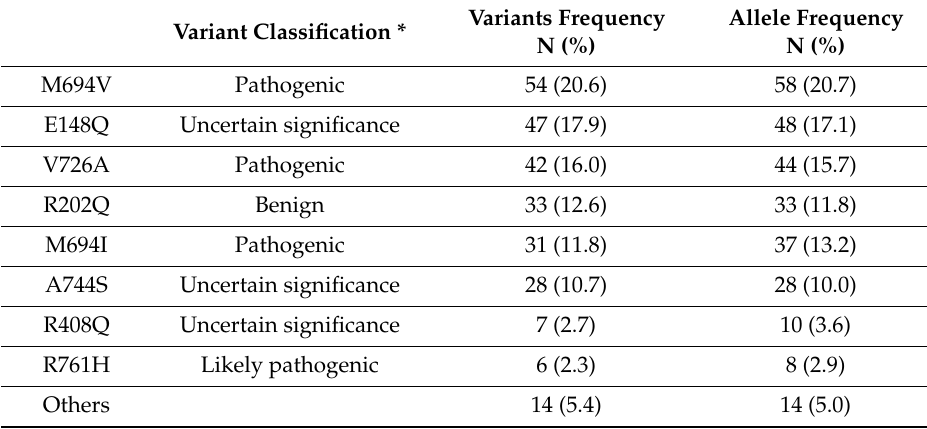
Table 2. Distribution of MEFV variants and allele frequencies among participants.